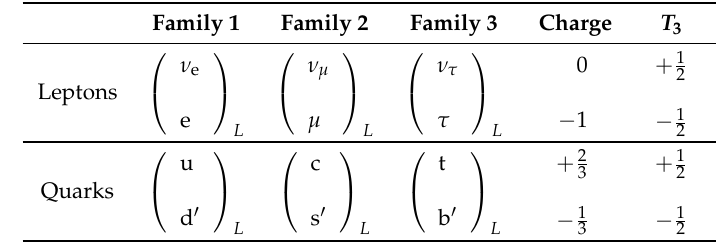
Table 1. Leptons and quarks, the three families of basic fermions. T 3 is the third component of the weak isospin; index L stands for the left polarization of the weak isospin doublets; and the apostrophe indicates the mixed quark states. Family 1 Family 2 Family 3 Charge T